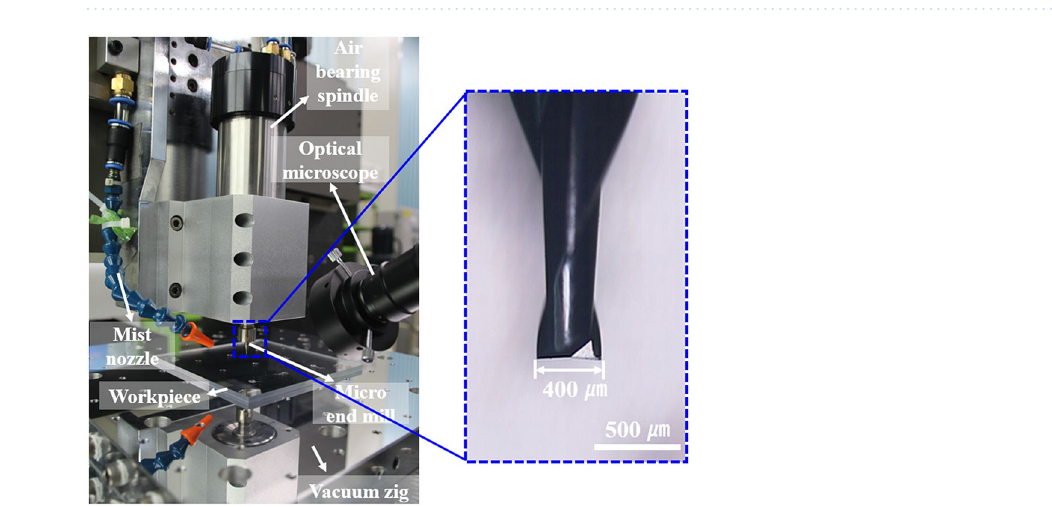
Figure 5. A schematic diagram showing the developed manufacturing processes for microwave absorber with resistive double square loop on a PMMA.